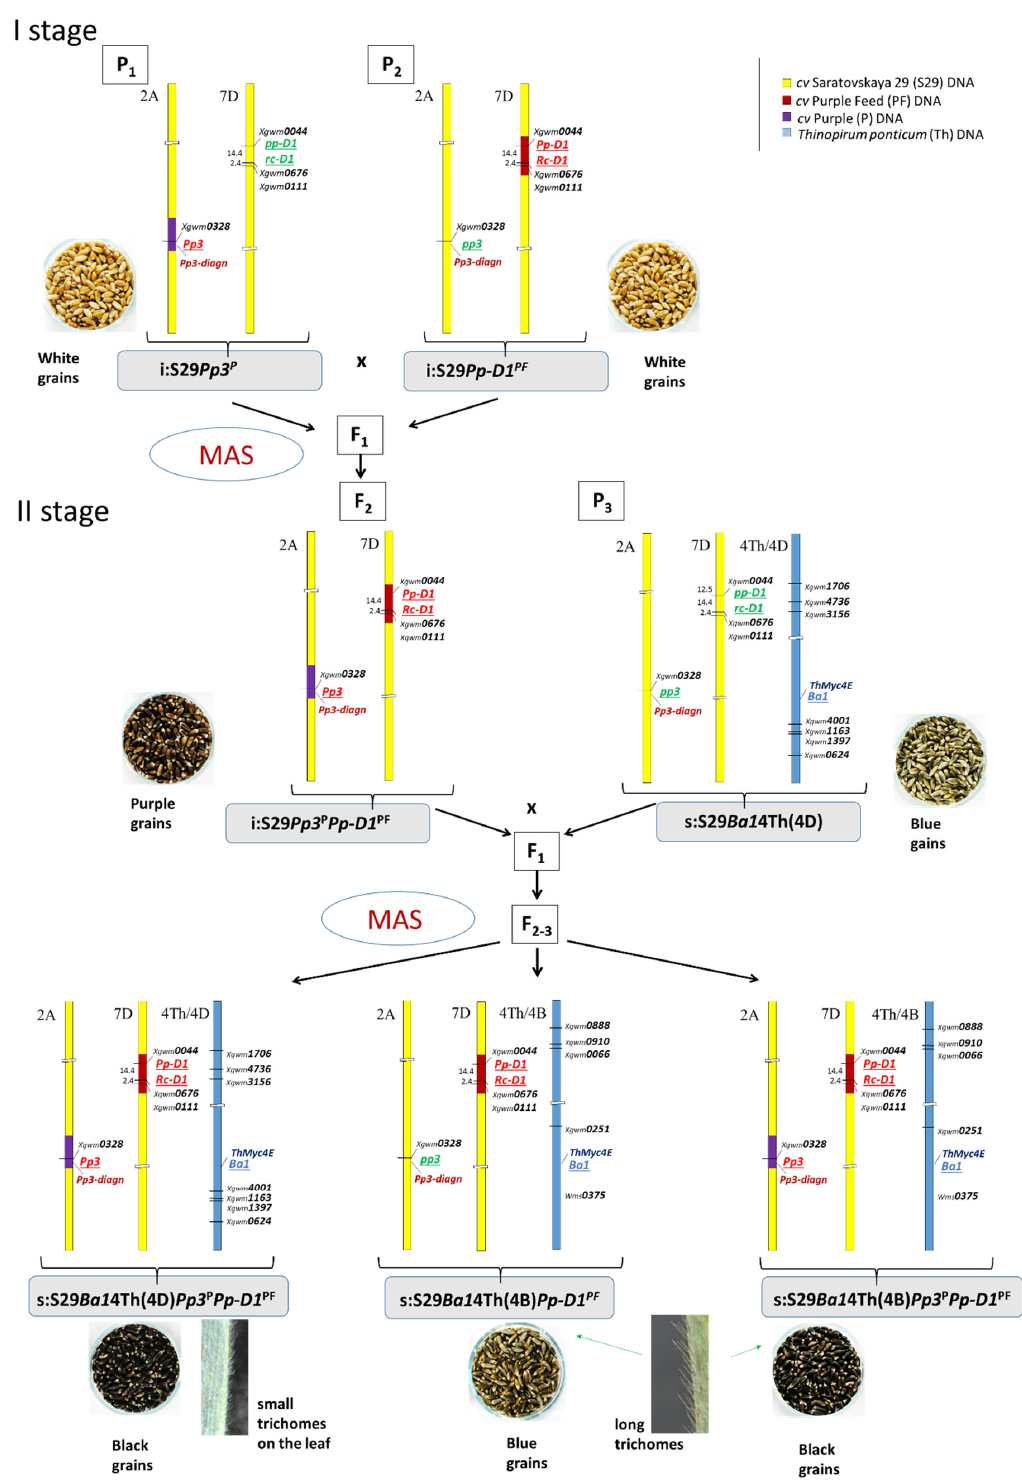
Figure 1. The crossing scheme and marker-assisted selection (MAS) of the homozygous near-isogenic and substitution purple-, blue-, and black-grained lines in the genetic background of cv. Saratovskaya 29. Where: obtaining the isogenic purple-grained line with minimal recombinant regions in the chromosomes (stage I), obtaining the black-grained lines (stage II). An outline of wheat chromosomes with anthocyanin biosynthesis regulatory genes and intragenic ( Pp3-diagnostic and ThMyc4E-specific ) and microsatellite markers is